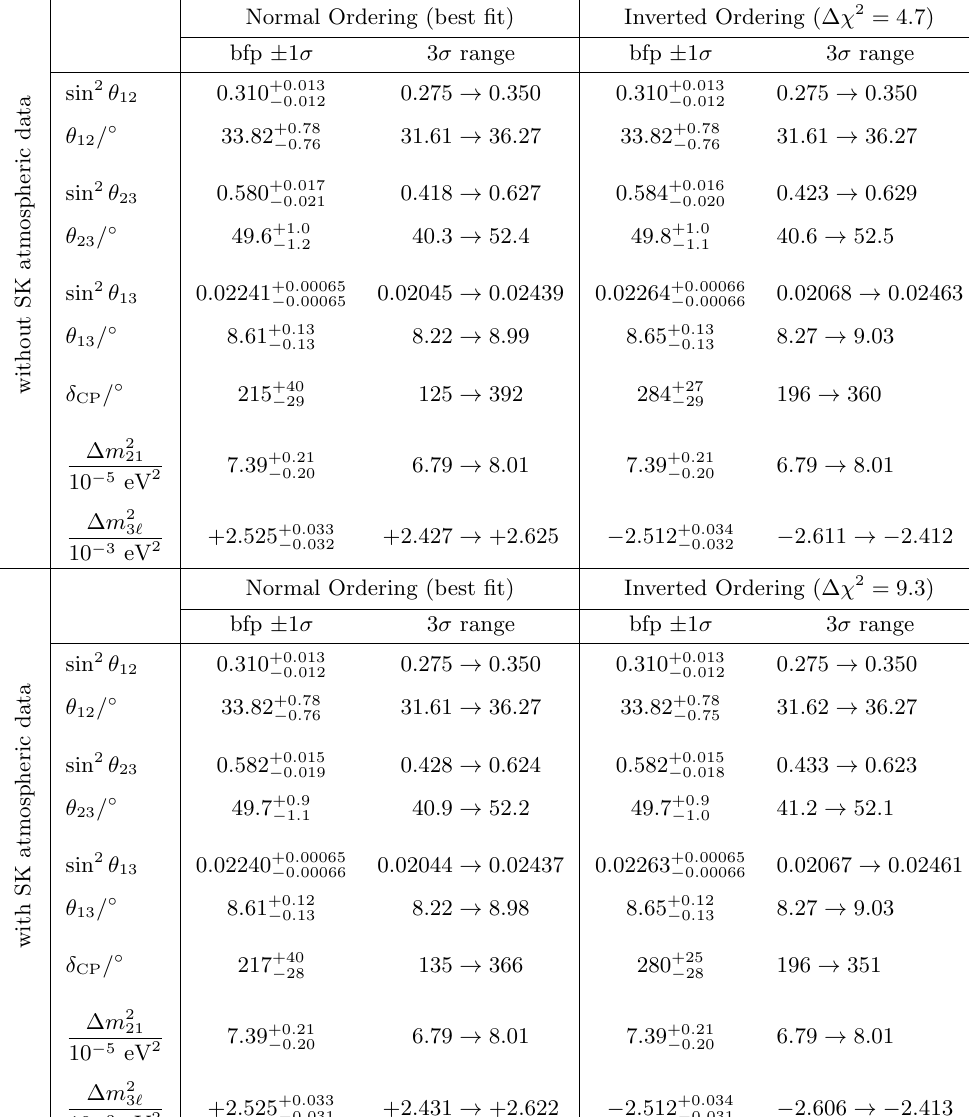
Table 1 . Three-(cid:13)avour oscillation parameters from our (cid:12)t to global data. The numbers in the 1st (2nd) column are obtained assuming NO (IO), i.e., relative to the respective local minimum. Note that (cid:1) m 2 (cid:17) (cid:1) m 2 > 0 for NO and (cid:1) m 2 (cid:17) (cid:1) m 2 < 0 for IO. The results shown in the upper 31 32 3 ‘ 3 ‘ (lower) table are without (with) adding the tabulated SK-atm (cid:1) (cid:31) 2 .